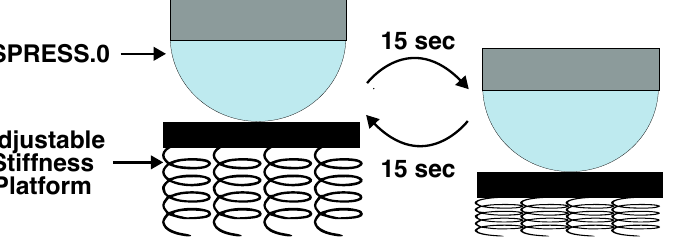
Figure 11. Compression of the palpation platform. The number of springs may be altered to change the linear stiffness of the